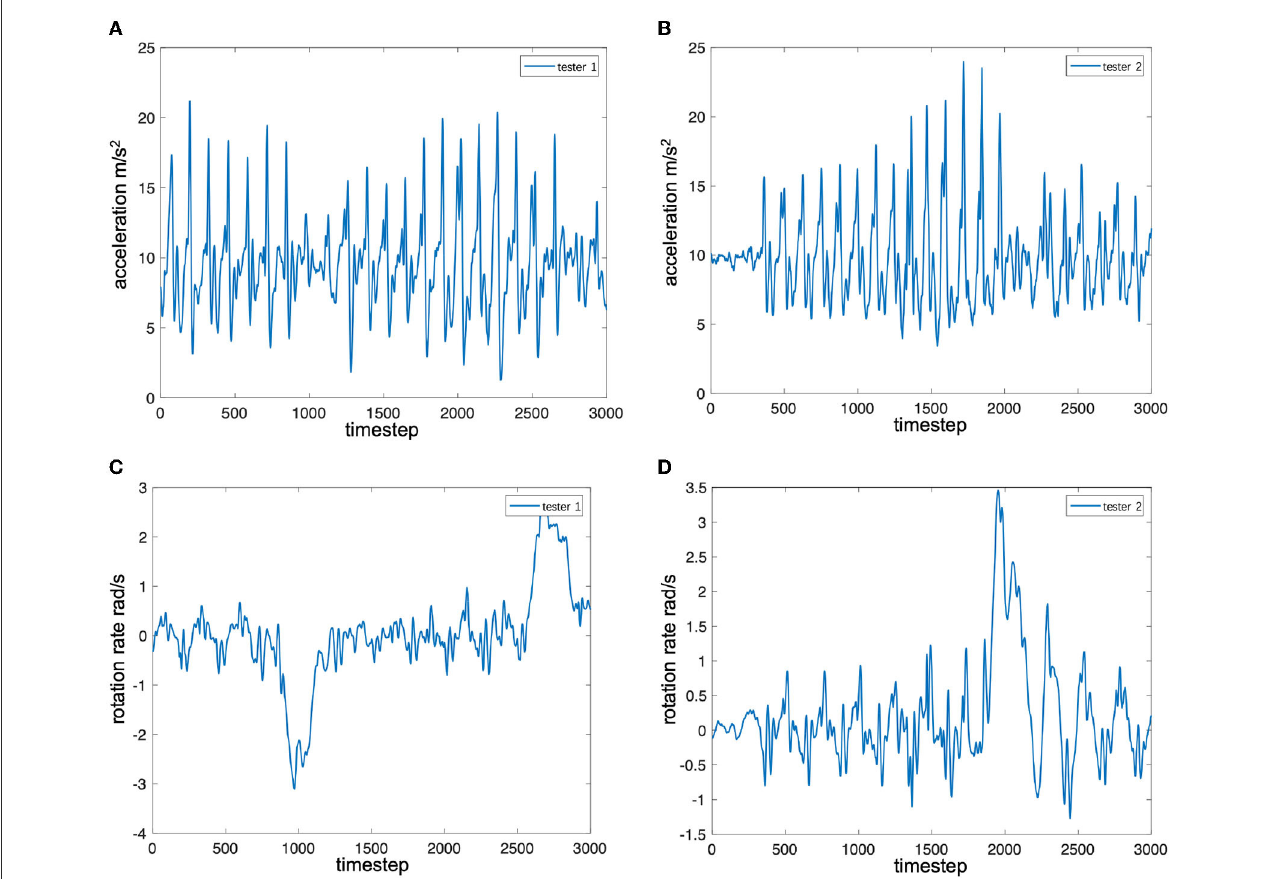
FIGURE2 Signal sequence of inertial sensors. (A) Accelerator along z-axis for tester 1 (1.76m). (B) Accelerator along z-axis for tester 2 (1.63m). (C) Gyroscope along z-axis for tester 1 (1.76m). (D) Gyroscope along z-axis for tester 2 (1.63